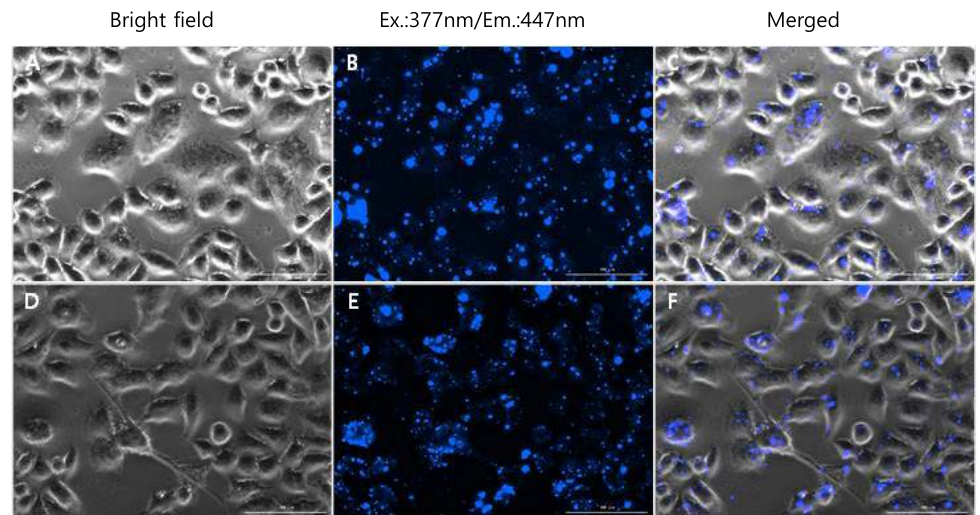
Figure 8. Cellular images of HeLa cells treated with the pTPEP-SiO 2 ( A – C ) and mTPEP-SiO 2 ( D – F ) nanoparticles. The images of HeLa cells were taken with a 20× optical lens and fluorescence optics (excitation at 377 nm and emission at 447 nm) after 2 h incubation with 40 µ g/mL of mTPEP-NPs and pTPEP-NPs in the dark condition. Scale bar represents 100 µm.